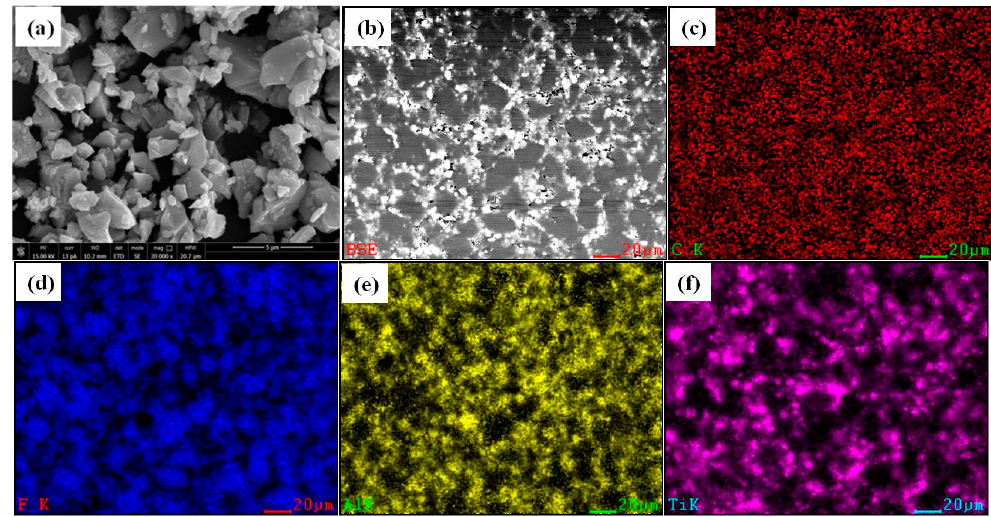
Figure 3. Microstructure and element distributions of the materials. ( a ) Scanning electron microscopy (SEM) image of pure TiH 2 powder; ( b ) backscattered SEM (BSE) image of PTFE/Al/TiH 2 (66.2/23.8/10); ( c ) C element; ( d ) F element; ( e ) Al element; and ( f ) Ti element.